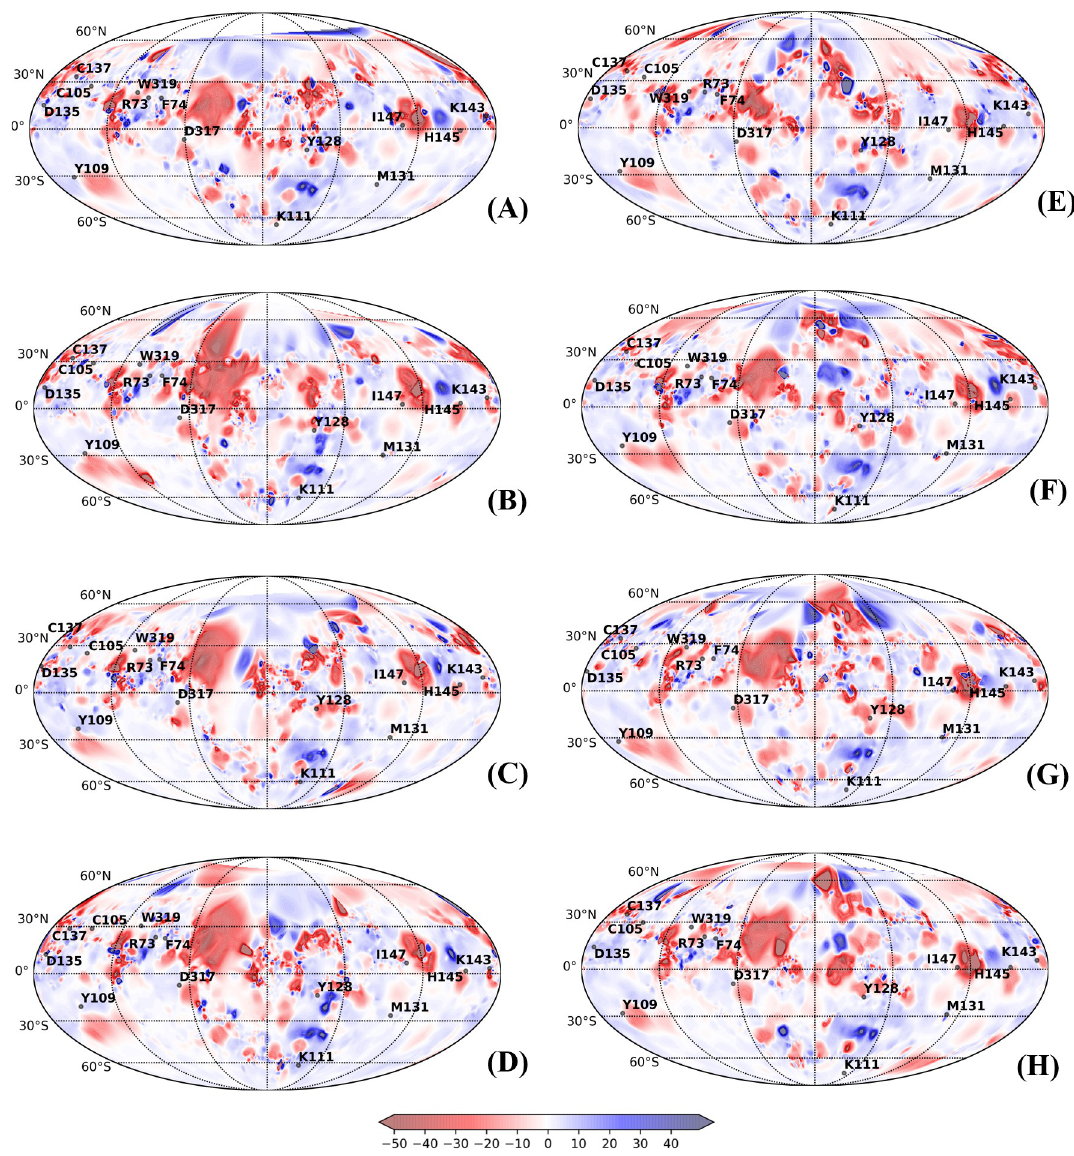
Fig 7. Protein surface topography representing molecular electrostatic potentials (MEP) localized to the CRD region with fourteen key residues were mapped onto 2D spherical projections for visual comparison of free and bound forms of Calreticulin in Humans (CRTH): (A) Free_Clus1; (B) Free_Clus2; (C) Free_Clus3; (D) Free_Clus4; (E) Complex_Clus1; (F) Complex_Clus2; (G) Complex_Clus3 and (H) Complex_Clus4.